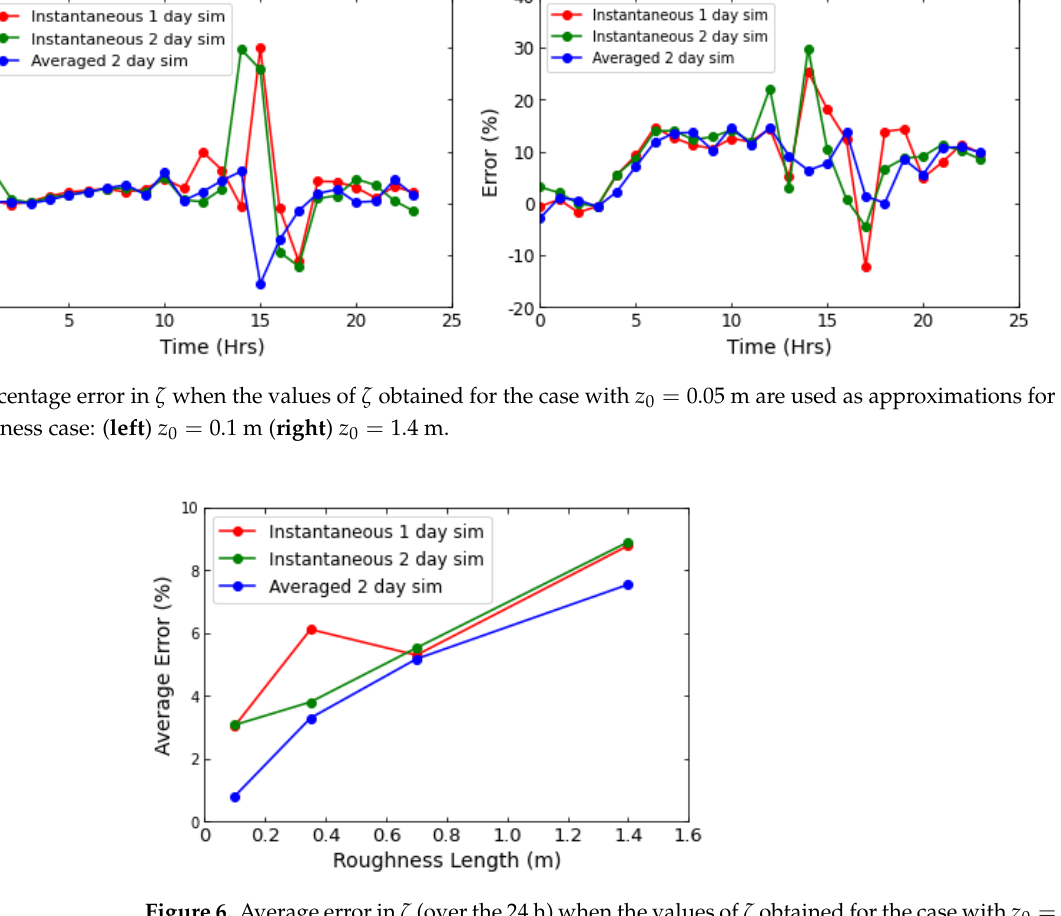
Figure 6. Average error in ζ (over the 24 h) when the values of ζ obtained for the case with z 0 = 0.05 m are used as approximations for higher roughness